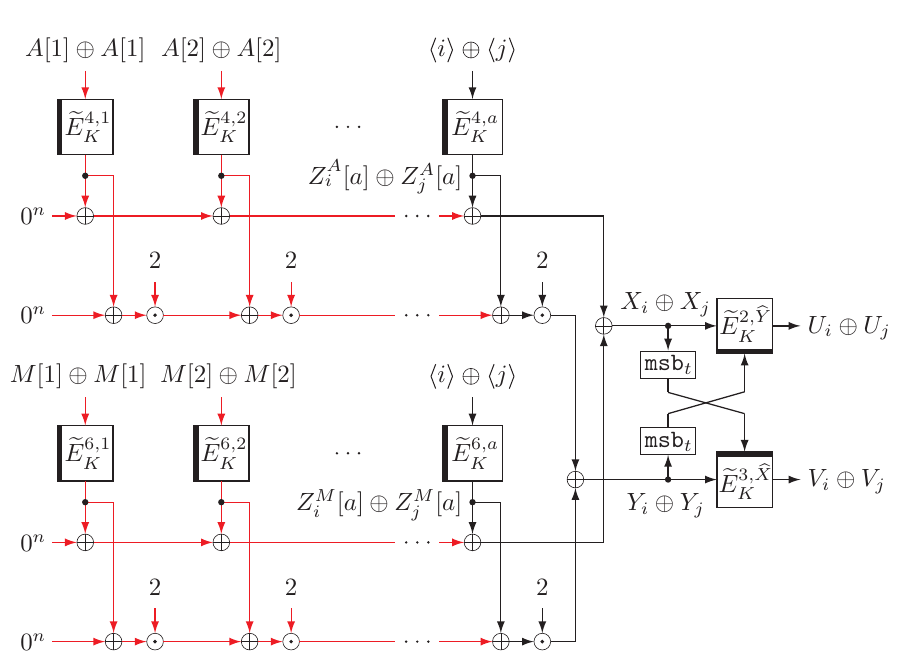
Figure 8: The attack against SIVx. The figure illustrates the XOR difference of internal variables for ( A i , M i ) and ( A j , M j ). A [1] , . . . , A [ a − 1] , M [1] , . . . , M [ a − 1] are fixed, and the red lines indicate the zero